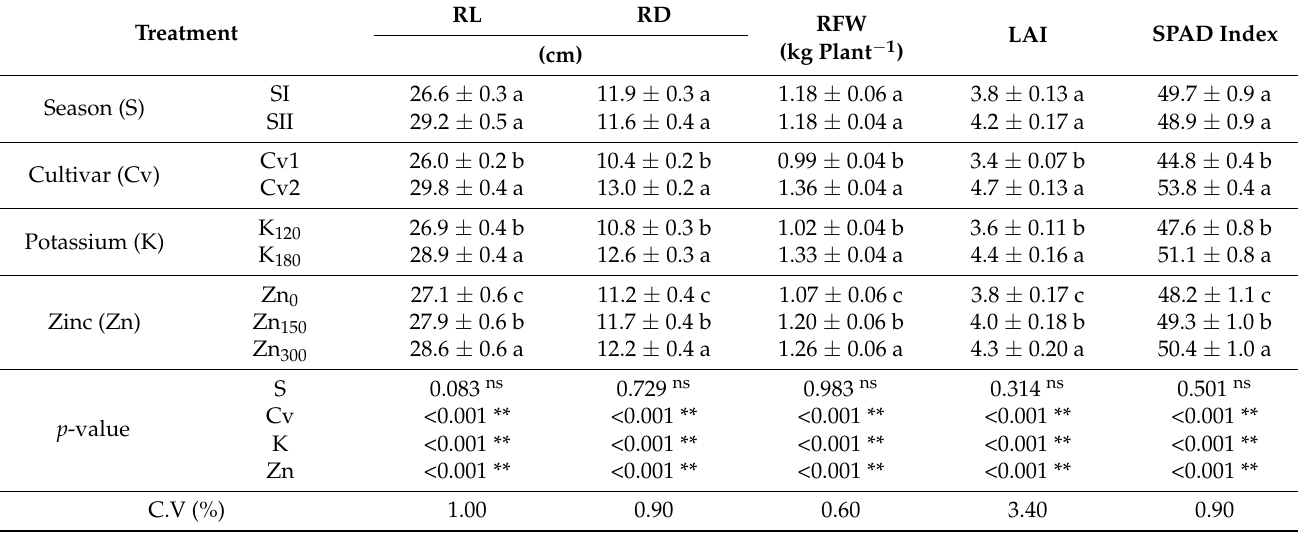
Table 3. Morphology (root length (RL), root diameter (RD), root fresh weight (RFW), leaf area index (LAI)) and SPAD index of two sugar beet cultivars (e.g., Kawemira (Cv1) and BTS 301 (Cv2)) affected by soil fertilization with two potassium levels (e.g., 120 (K 120 ) and 180 kg ha − 1 (K 180 )) and foliar application with three zinc levels (e.g., 0 (Zn 0 ), 150 (Zn 150 ), and 300